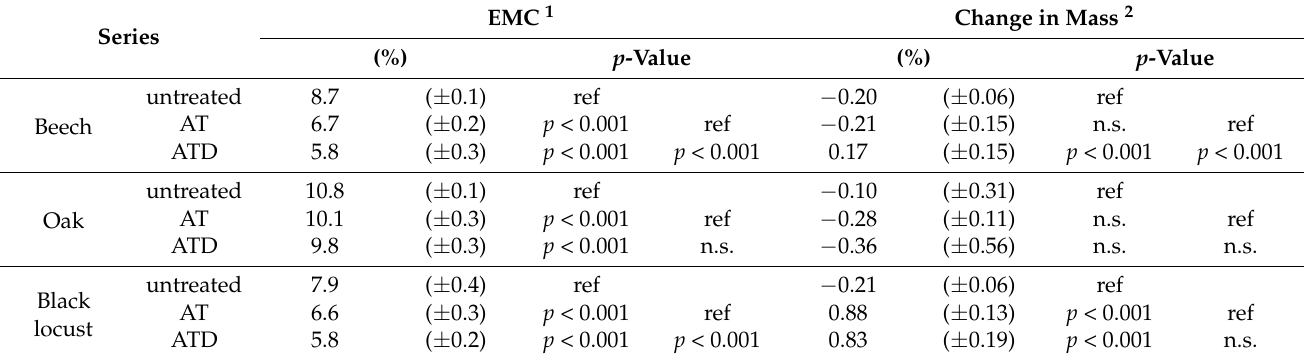
Table 1. Determined equilibrium moisture content (EMC) and change in mass.